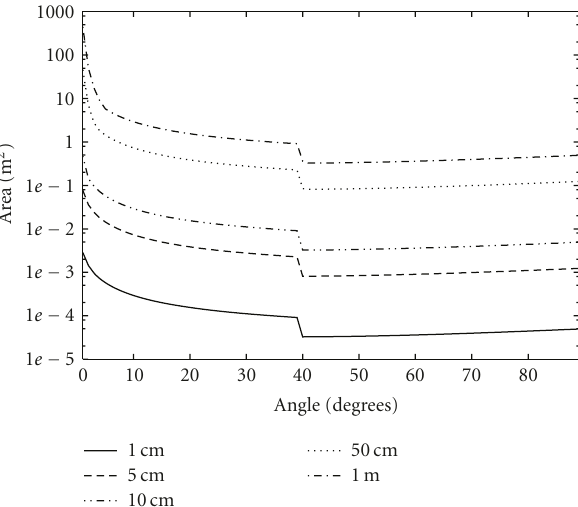
Figure 14: Transmitted power P t and minimum required min for having the same area coverage as a transmitted power P ∗ Figure 15: Uncertainty area for N = 3 receivers and r = R = 50m, t min function of the angle θ (four receivers, R = 50 m). as a function of the angle θ and for di ff erent annulus thickness values.